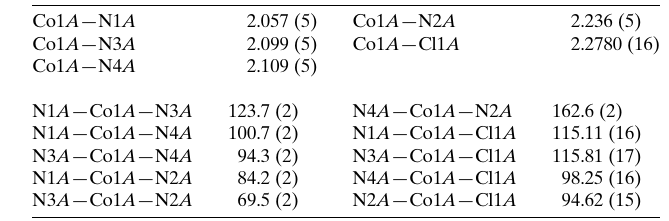
Table 3 Selected geometric parameters (A˚ , (cid:5) ) for [Co(Ppz)Cl]ClO 4 .